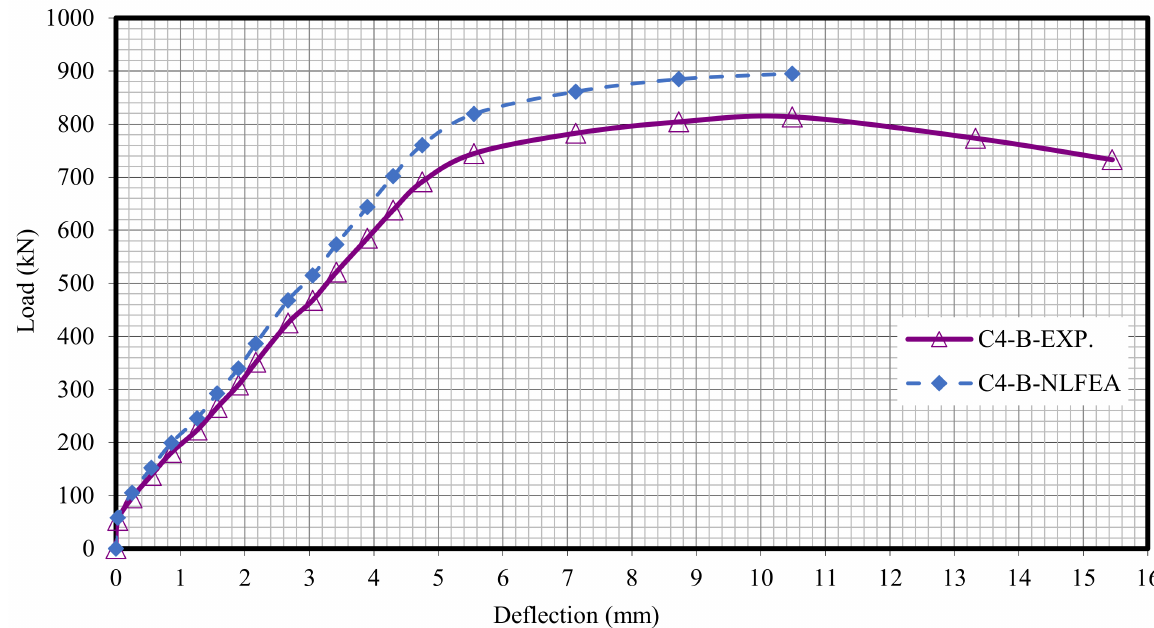
Figure 25. Load deflection of Column C4-B.